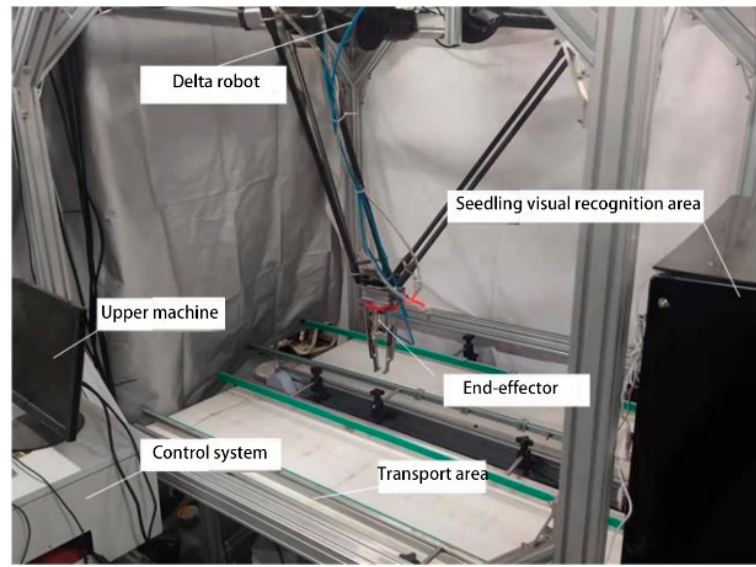
Figure 14. Whole machine physical diagram.